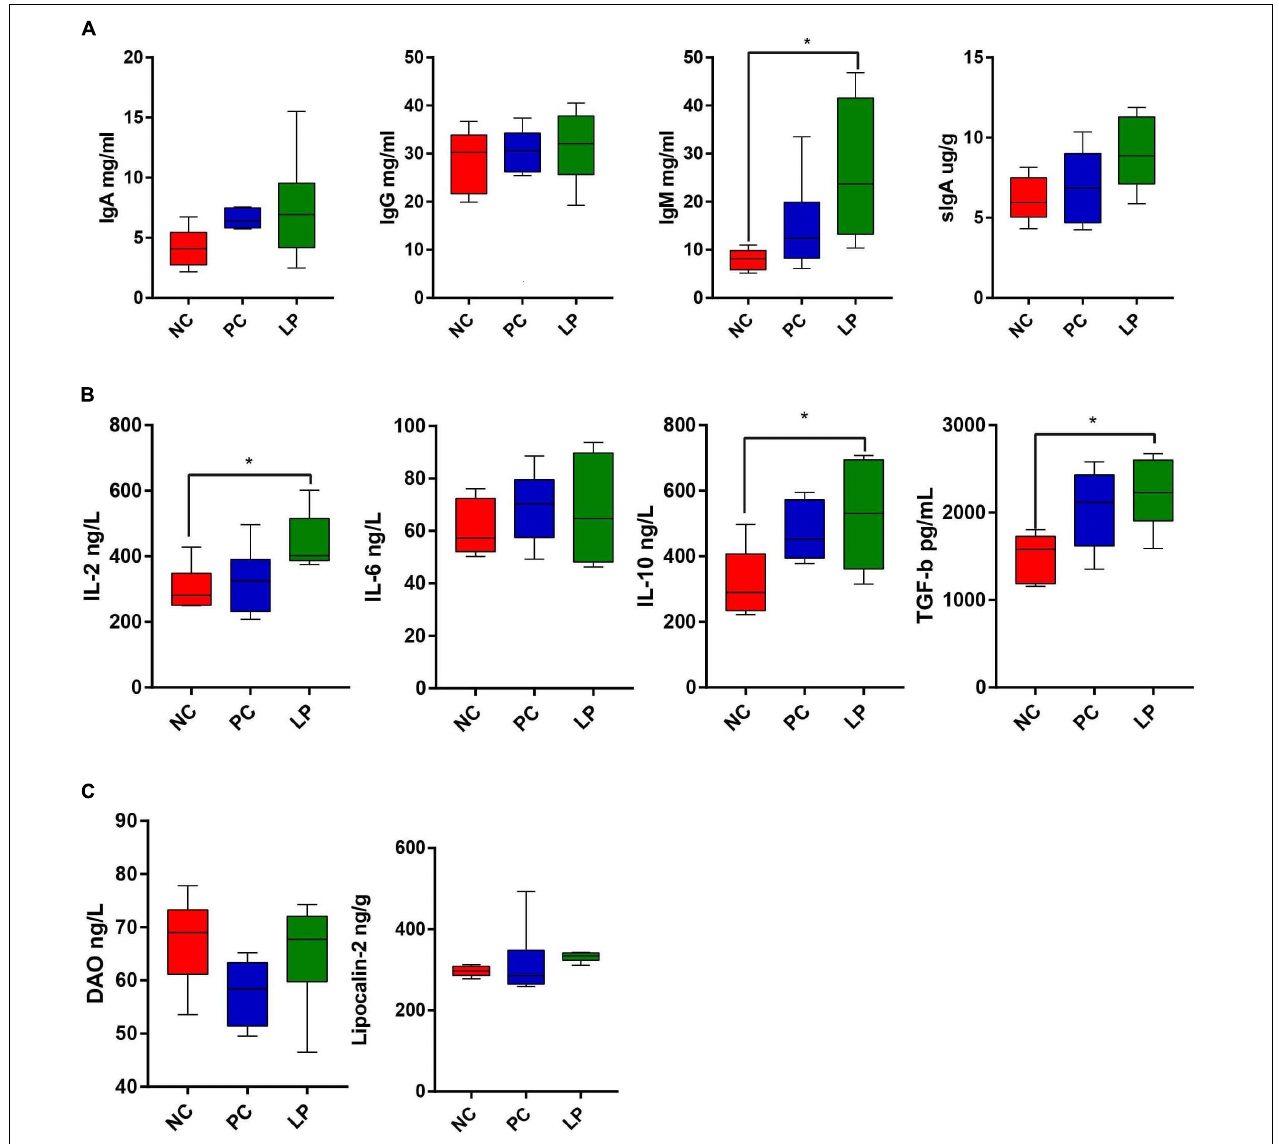
FIGURE 5 | Comparison of serum index among weaning piglets in NC, PC, and LP groups. (A) Serum IgG, IgA, IgM, and intestinal SIgA levels among the three groups ( n = 6). (B) Serum cytokines IL-2, IL-6, IL-10, and TGF- β levels among the three groups ( n = 6). (C) Levels of intestinal permeability-related biomarkers DAO and colonic content of Lipocalin-2 among the three groups ( n = 6). ∗ P < 0.05. IgG, immunoglobulin G; IgA, immunoglobulin A; IgM, immunoglobulin M; sIgA, secretory IgA; TGF- β , transforming growth factor β ; IL-2, interleukin 2; IL-6, interleukin 6; IL-10, interleukin 10; DAO, diamine